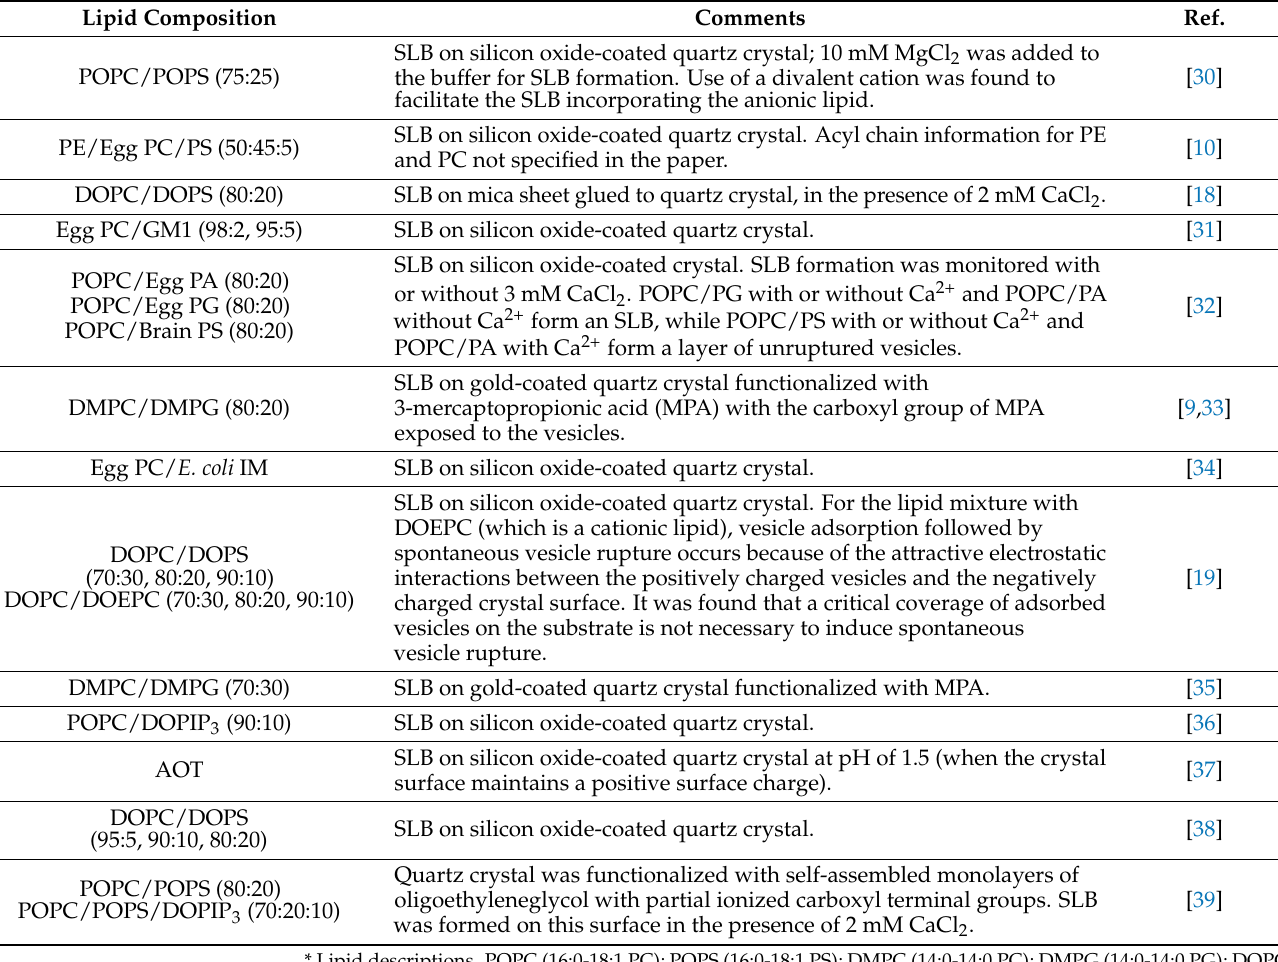
Table 2. Current status of formation of anionic lipids * containing SLB for QCM-D. Lipid